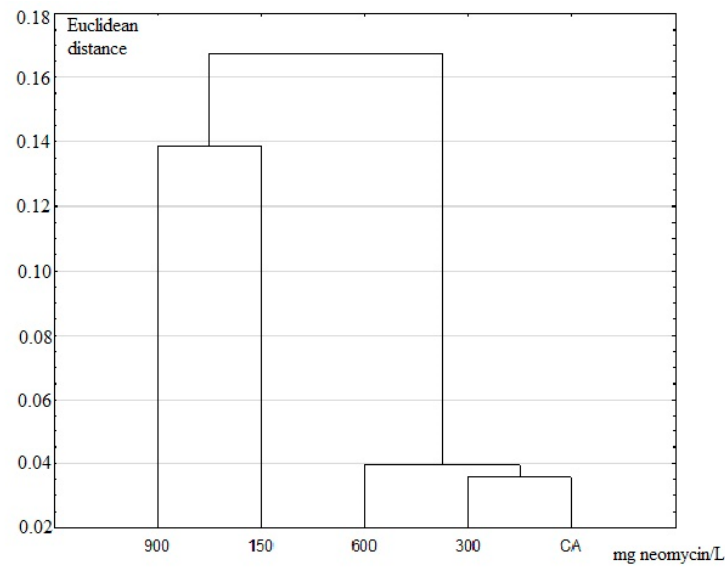
Figure9. UPGMAdendrogrambasedonthreestudiedveins. 900–150dosesofneomycin(150–900mg / L), Figure 9. UPGMA dendrogram based on three studied veins. 900-150 doses of neomycin (150-900 CA—the control mg/L), CA – the control group.